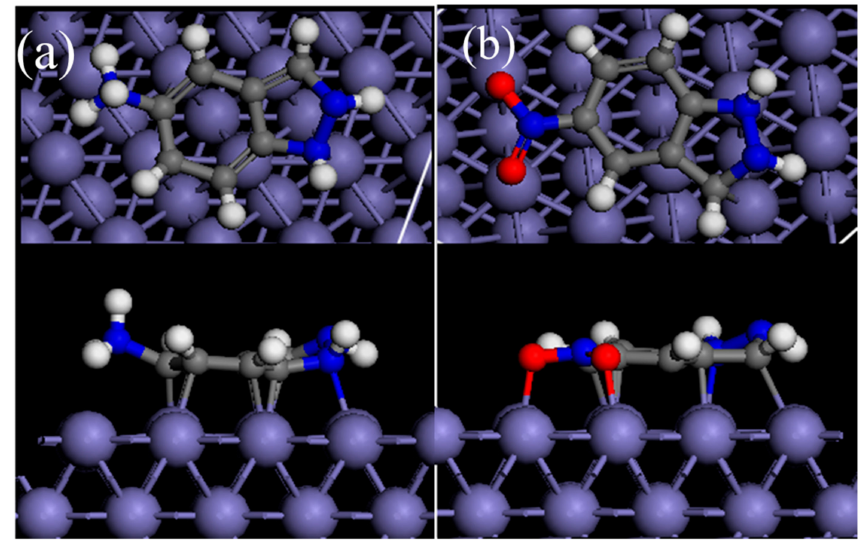
Figure 7. Stable adsorption configurations (side and top view) of ( a ) AIA-2H + and ( b ) NIA-H +